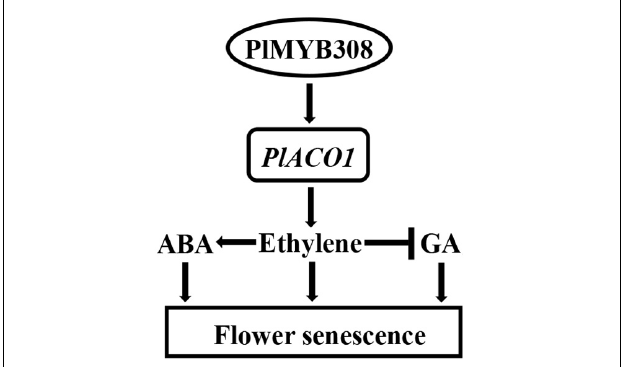
FIGURE 7 | The model of PlMYB308 -mediated regulation of flower senescence. Arrows indicate promotion, and leading dashes indicate